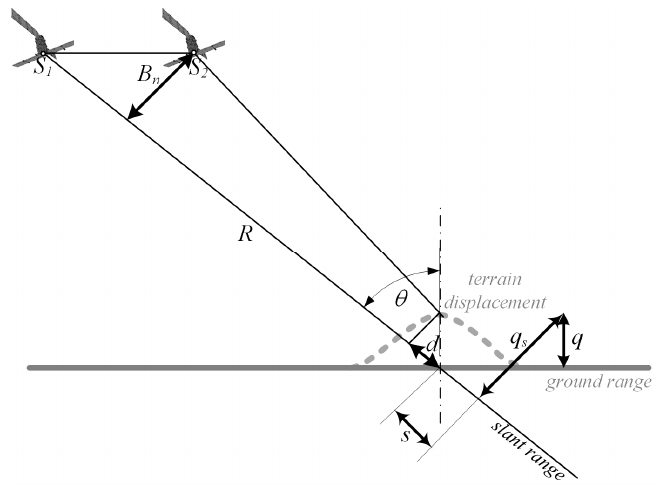
Figure 1. The basic geometry of DInSAR. With precise knowledge of the satellite positions and times of acquisition at S 1 and S 2